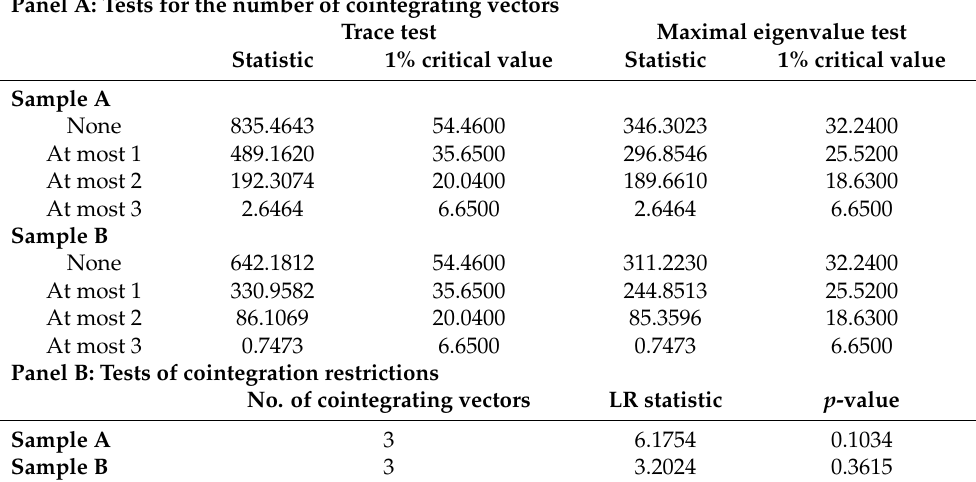
Table A2. Cointegration tests.